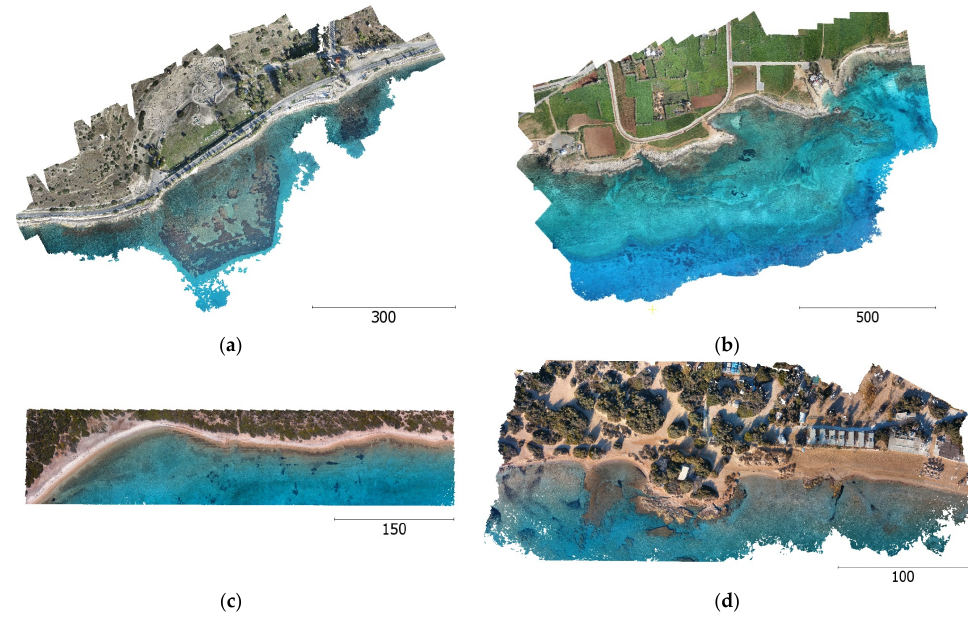
Figure 2. The initial dense point clouds for Amathounta ( a ), Agia Napa ( b ), Cyclades-1 ( c ), and Cyclades-2 ( d ) test sites. Scale bars are in meters.